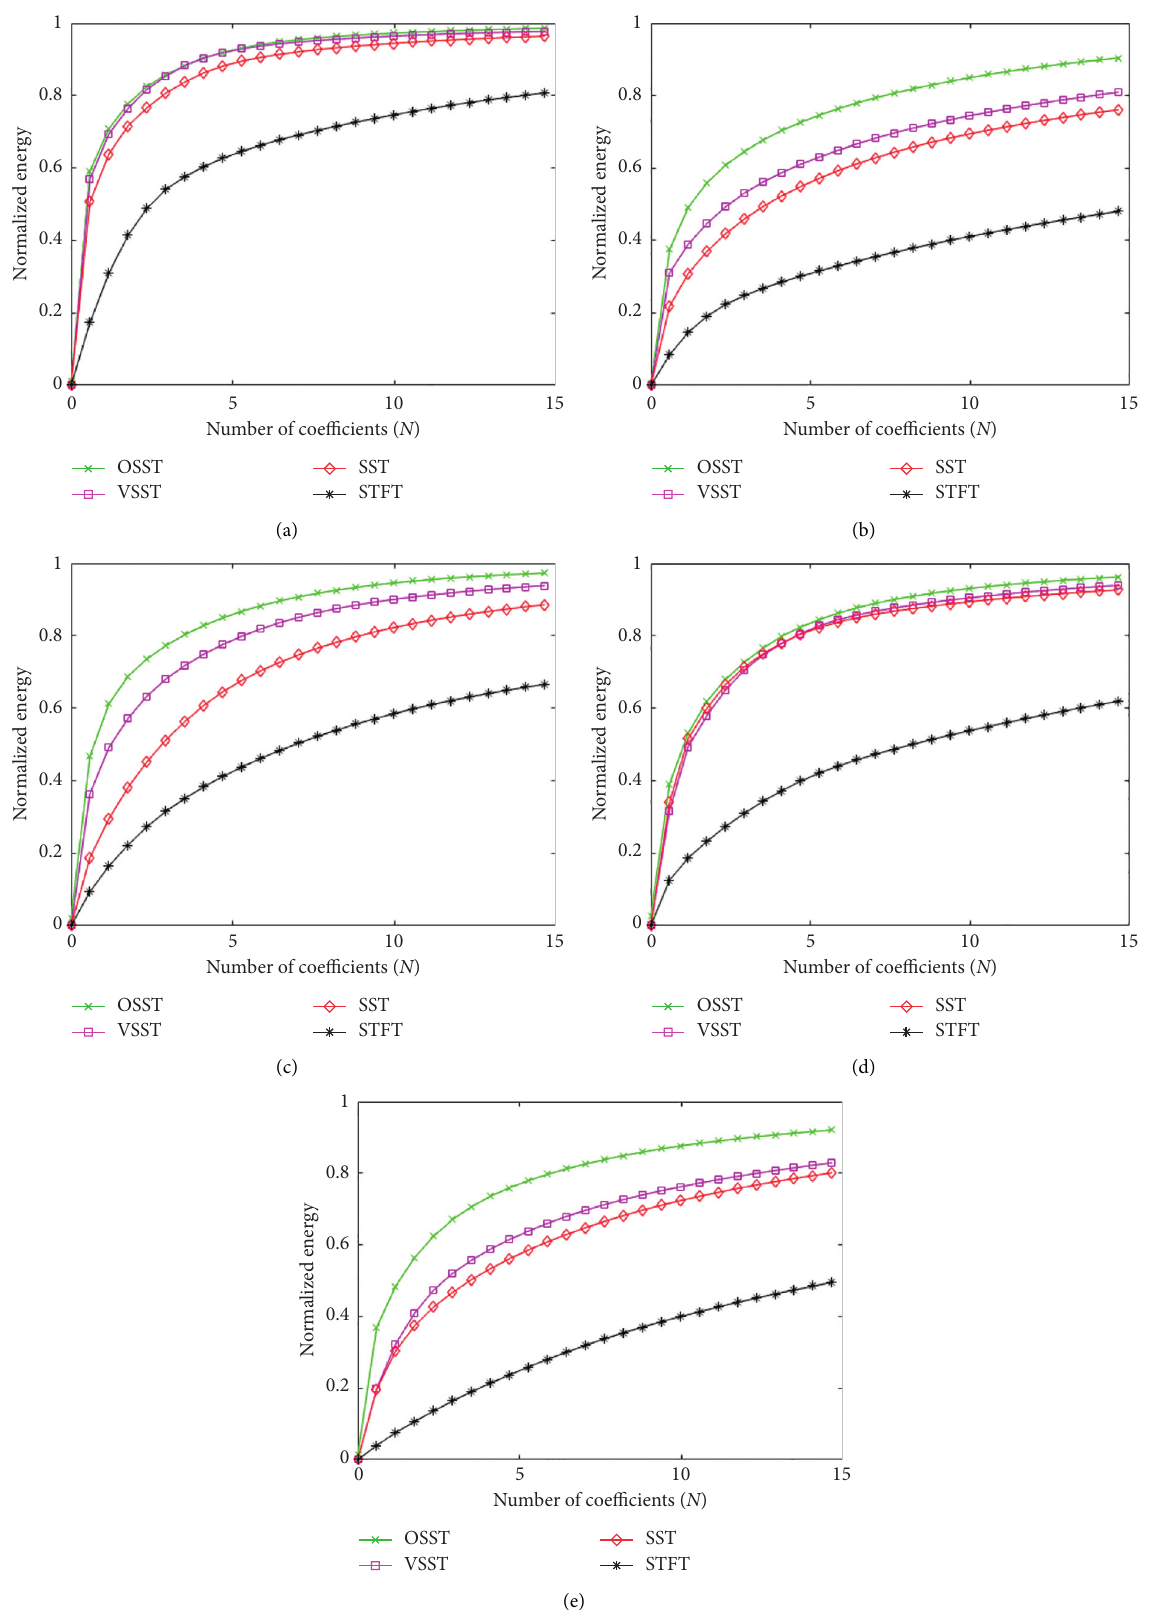
Figure 9: Normalized energy as a function of the number of coefficients for experimental signals: (a) fault-free, (b) ball fault, (c) inner ring fault, (d) outer ring fault, and (e) combined fault of inner and outer